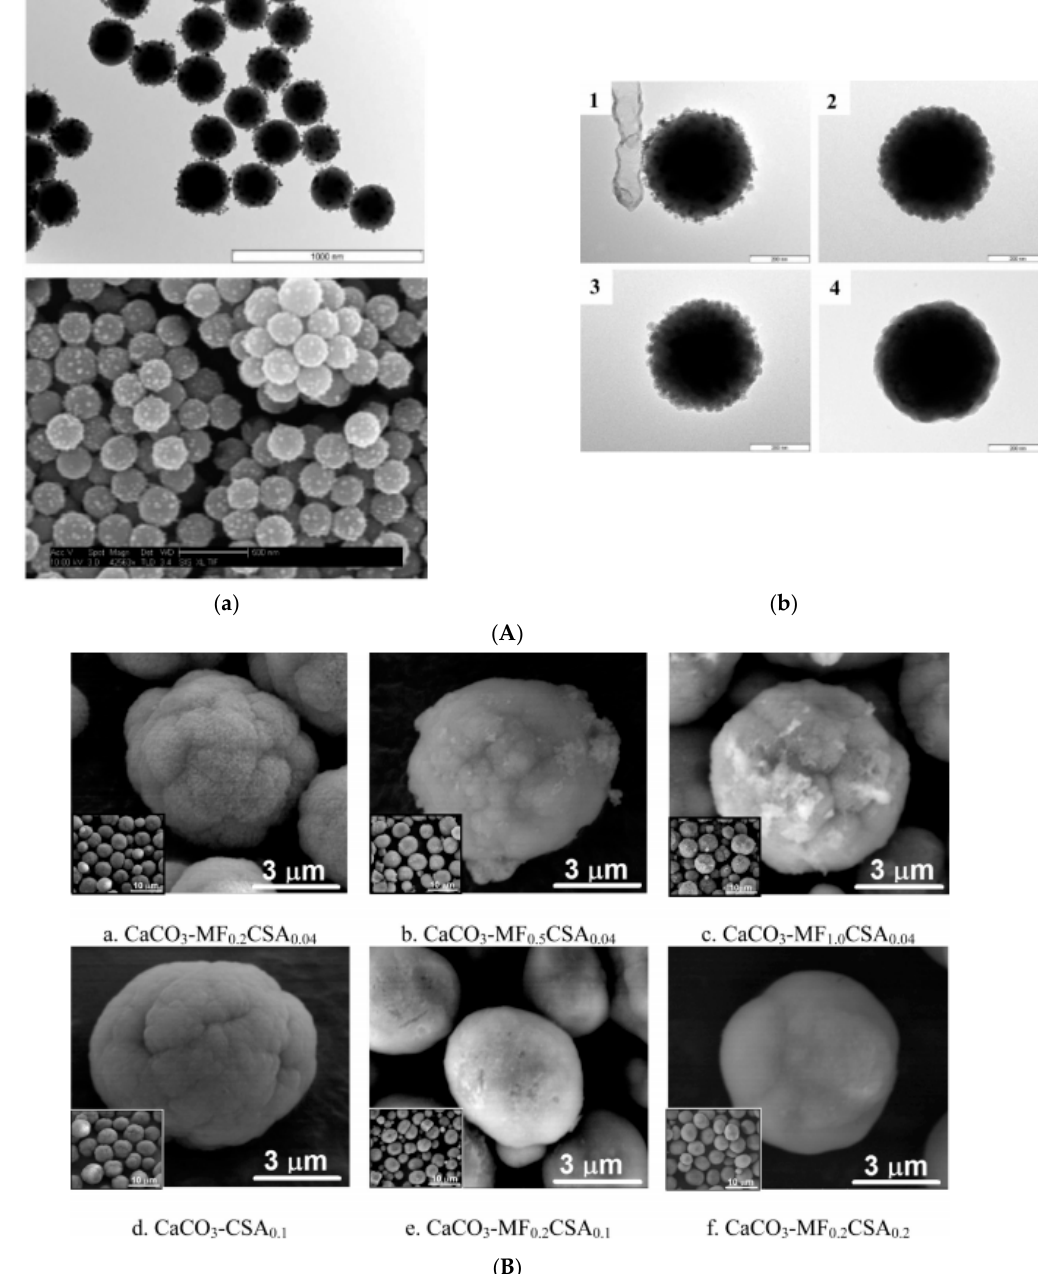
Figure 7. ( A ) ( a ) TEM (top) and corresponding SEM picture (bottom) of silica–cobalt ferrite nanocomposite particles ( b ) Silica growth onto composite particles monitored by TEM, which shows the gradually increasing silica layer thickness from no silica present in picture 1 to a fully grown silica layer in picture 4. (Reprinted with permission from [52] Copyright 2005 American Chemical Society). ( B ) Magnetoresponsive chondroitin sulfate-functionalized CaCO 3 microparticles. The influence of CSA and magnetic fluid (MF) content on the CaCO 3 − MF − CSA composite size, shape, and morphology, as evidenced by SEM (reprinted with permission from [167]. Copyright 2013 American Chemical Society).